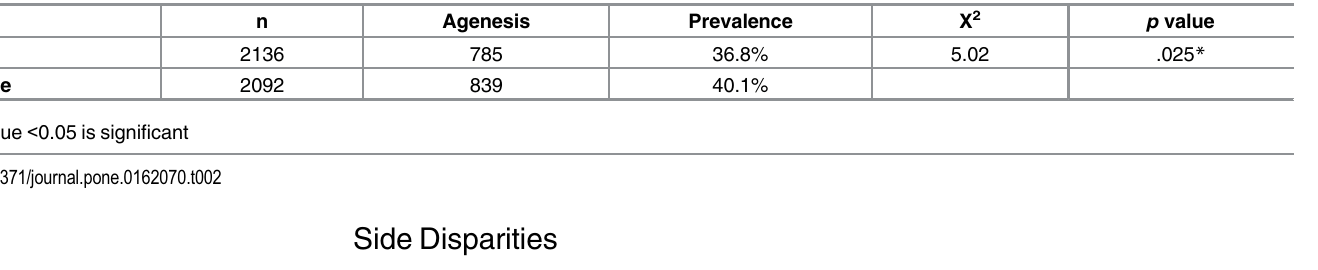
Table 2. The frequency of agenesis according to sex.